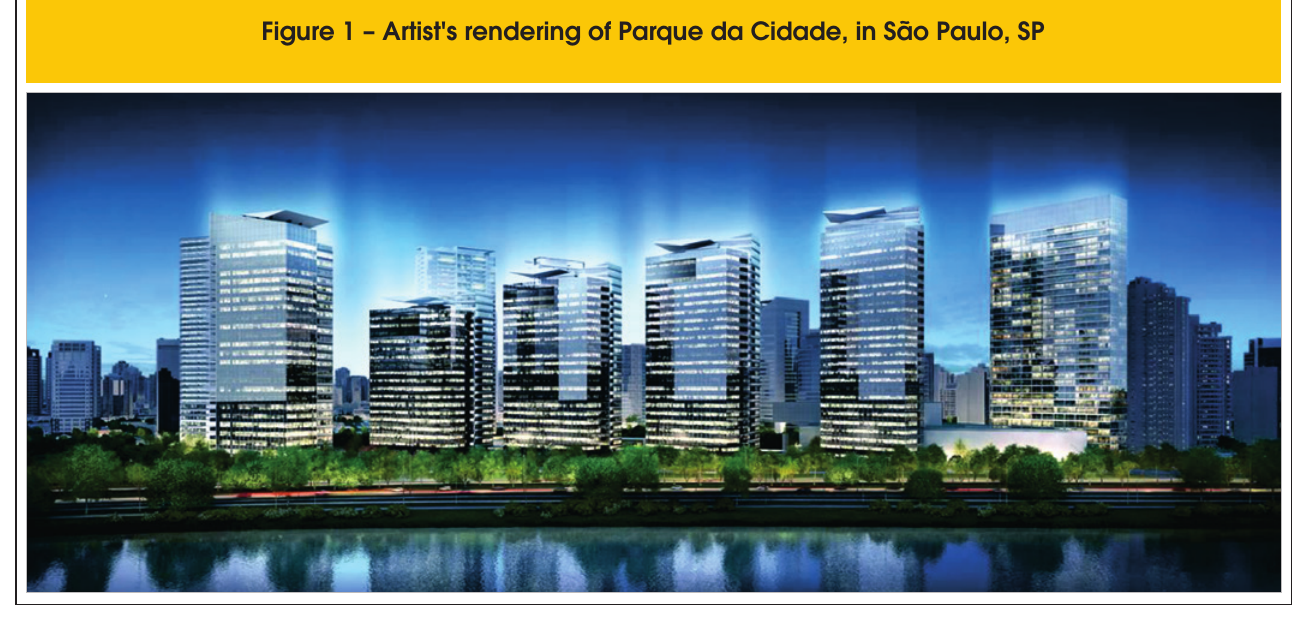
Figure 1 – Artist's rendering of Parque da Cidade, in São Paulo,